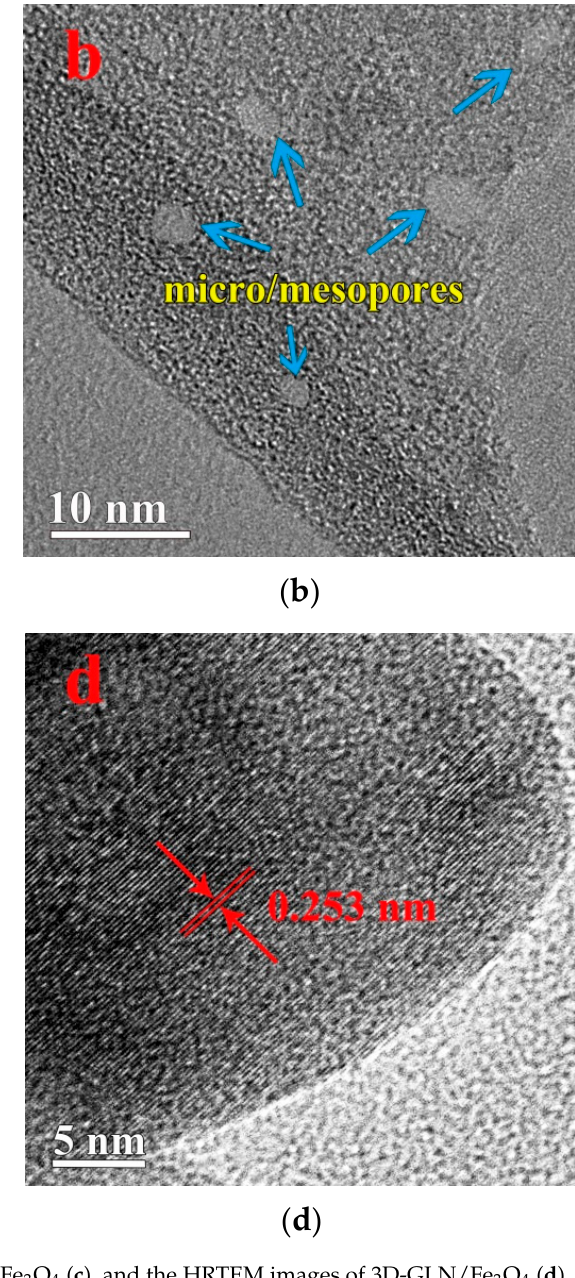
Figure 3. The TEM images of 3D-GLN ( a , b ) and 3D-GLN/Fe 3 O 4 ( c ), and the HRTEM images of 3D-GLN/Fe 3 O 4 ( d ). To explore the specific surface areas and porosity properties of the 3D-GLN and the 3D-GLN/Fe 3 O 4 , the N 2 adsorption/desorption isotherms were measured. According to Figure 4a, the 3D-GLN and the 3D-GLN/Fe 3 O 4 exhibited the combination characteristics of type II and type IV isotherms, which indicated that they exhibited the multilayer and pore structures. As demonstrated from the BET method analysis, the 3D-GLN and the 3D-GLN/Fe 3 O 4 exhibited the large specific surface areas of 1135.3 m 2 /g and 857.6 m 2